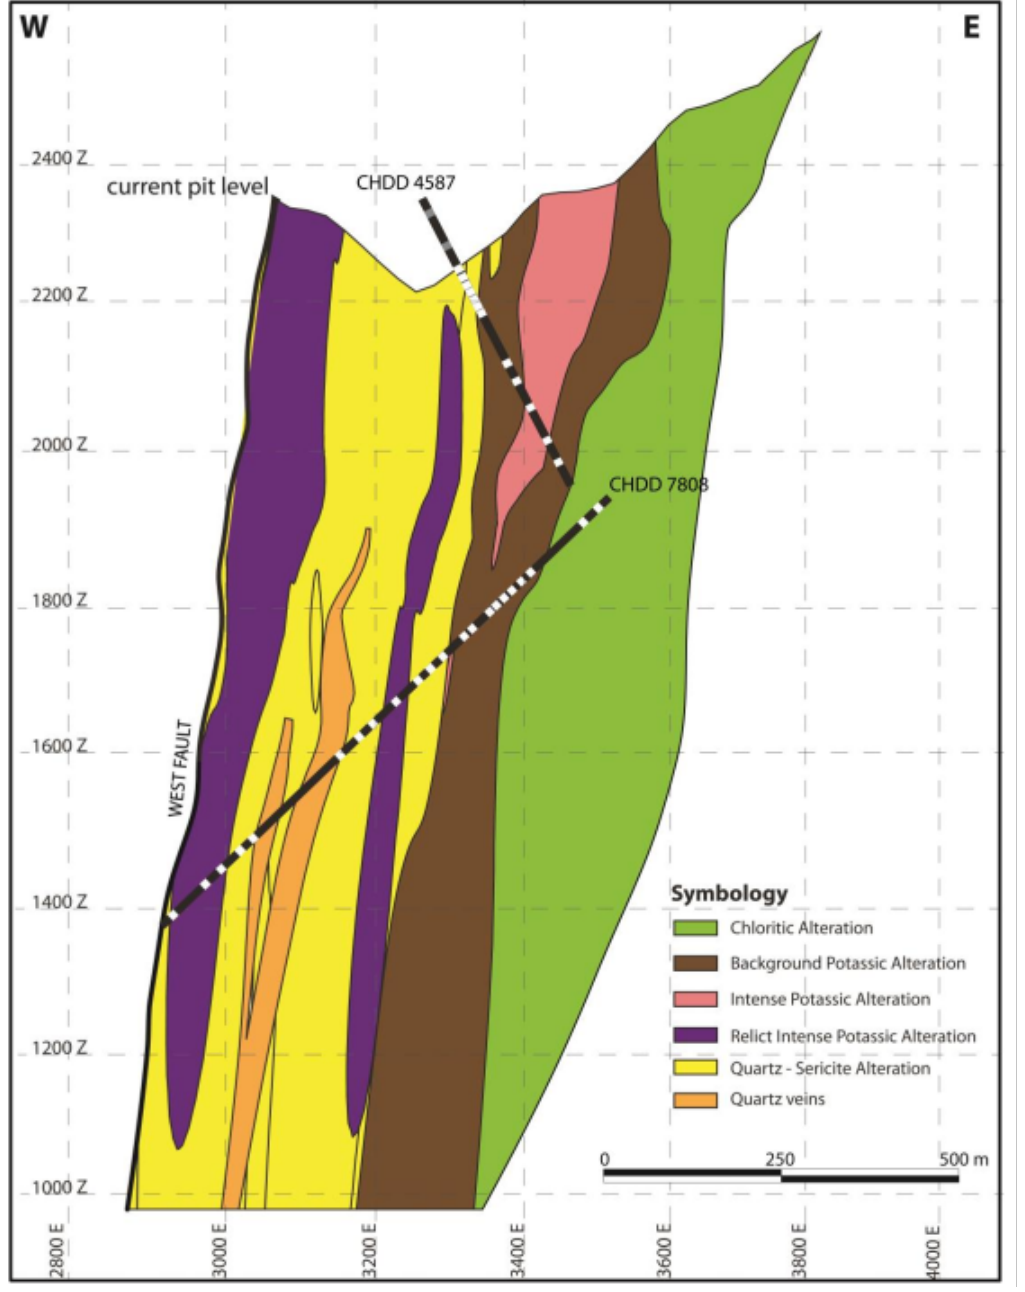
Figure 3. Representative cross-section showing the distribution of alteration zones in the Chuquicamata Underground mine. The upper limits of the alteration zones correspond to the bottom of the Chuquicamata open pit. Drill cores CHDD4587 and CHDD7808 are also shown. Relative positions of selected samples within the drill cores are shown in gray and